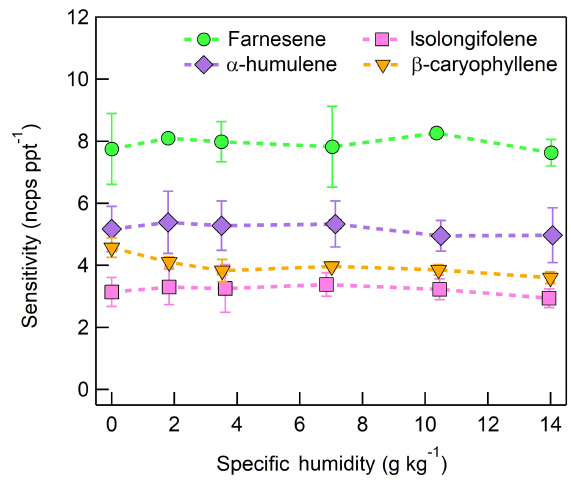
Figure 12. Humidity-dependent sensitivities of SQTs detected as C 15 H 24 (204 m/Q ). Error bars represent the standard deviation of triplicate measurements. All calibrations were performed in zero